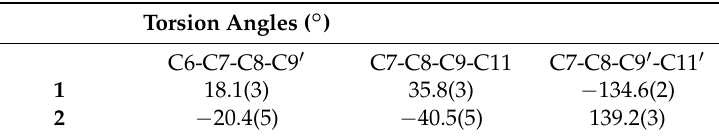
Table 3. Torsion angles for aromatic rings.